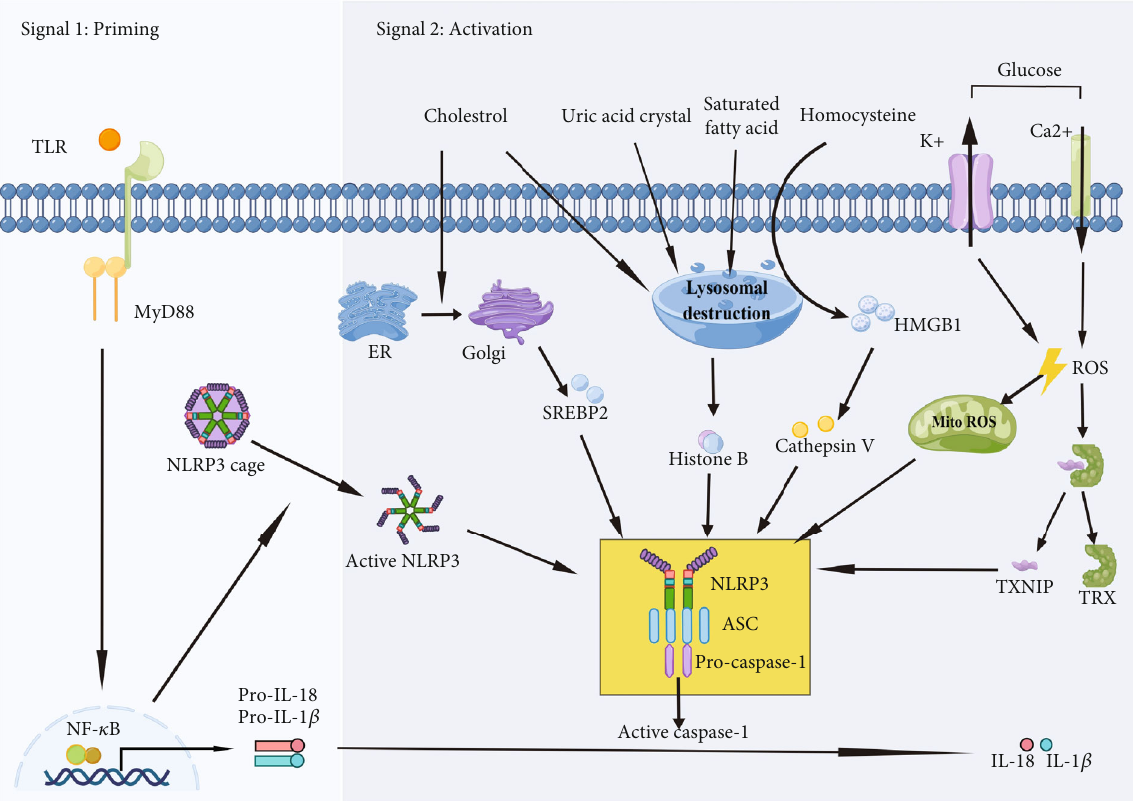
Figure 1: Speci fi c mechanisms of NLRP3 in fl ammasome activation by abnormal accumulation of